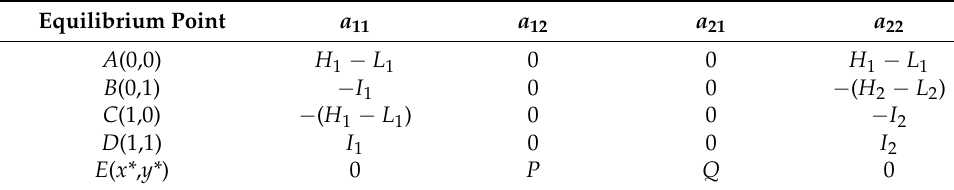
Table 2. Values at the local equilibrium